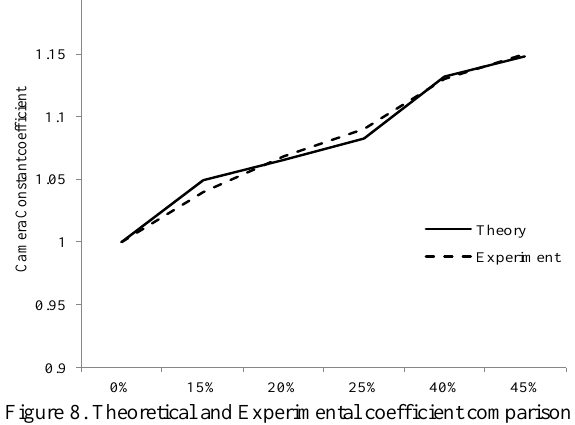
Figure 8. Theoretical and Experimental coefficient comparison regarding to the intervening water percentages Water Percentage